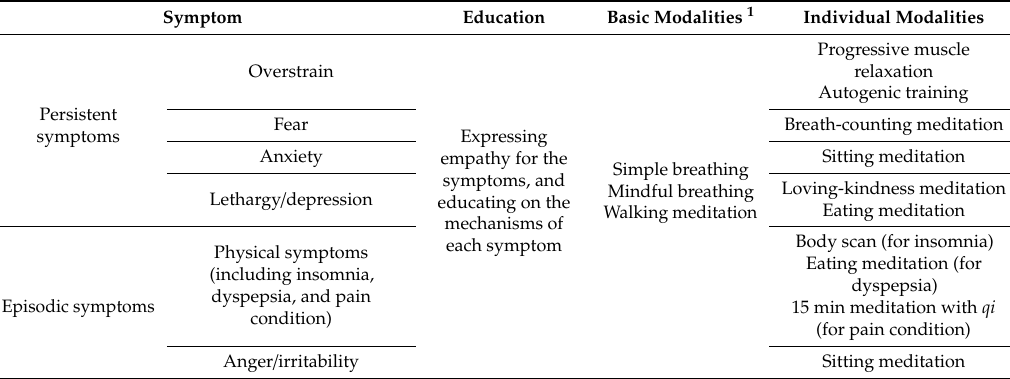
Table 3. Care algorithm of the manual.